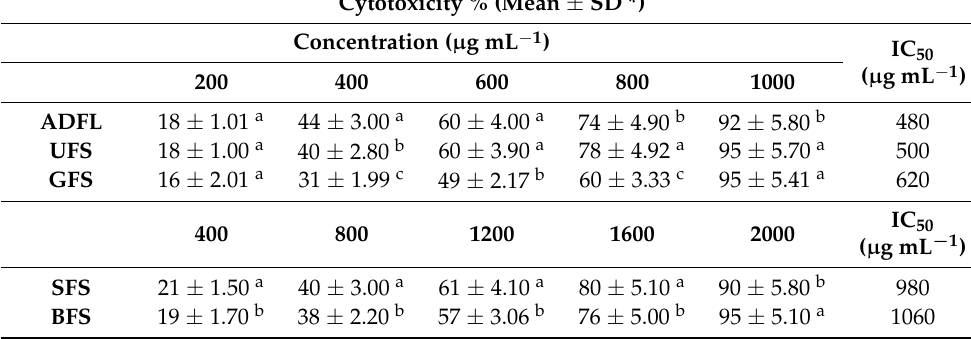
Table 3. Anti-proliferative activity (%) and IC 50 ( µ g mL − 1 ) values of ethanolic crude extracts of air-dried fenugreek leaves (ADFL), untreated fenugreek seeds (UFS), germinated fenugreek seeds (GFS), soaked fenugreek seeds (SFS), and boiled fenugreek seeds (BFS) against breast carcinoma cell line (MCF-7).